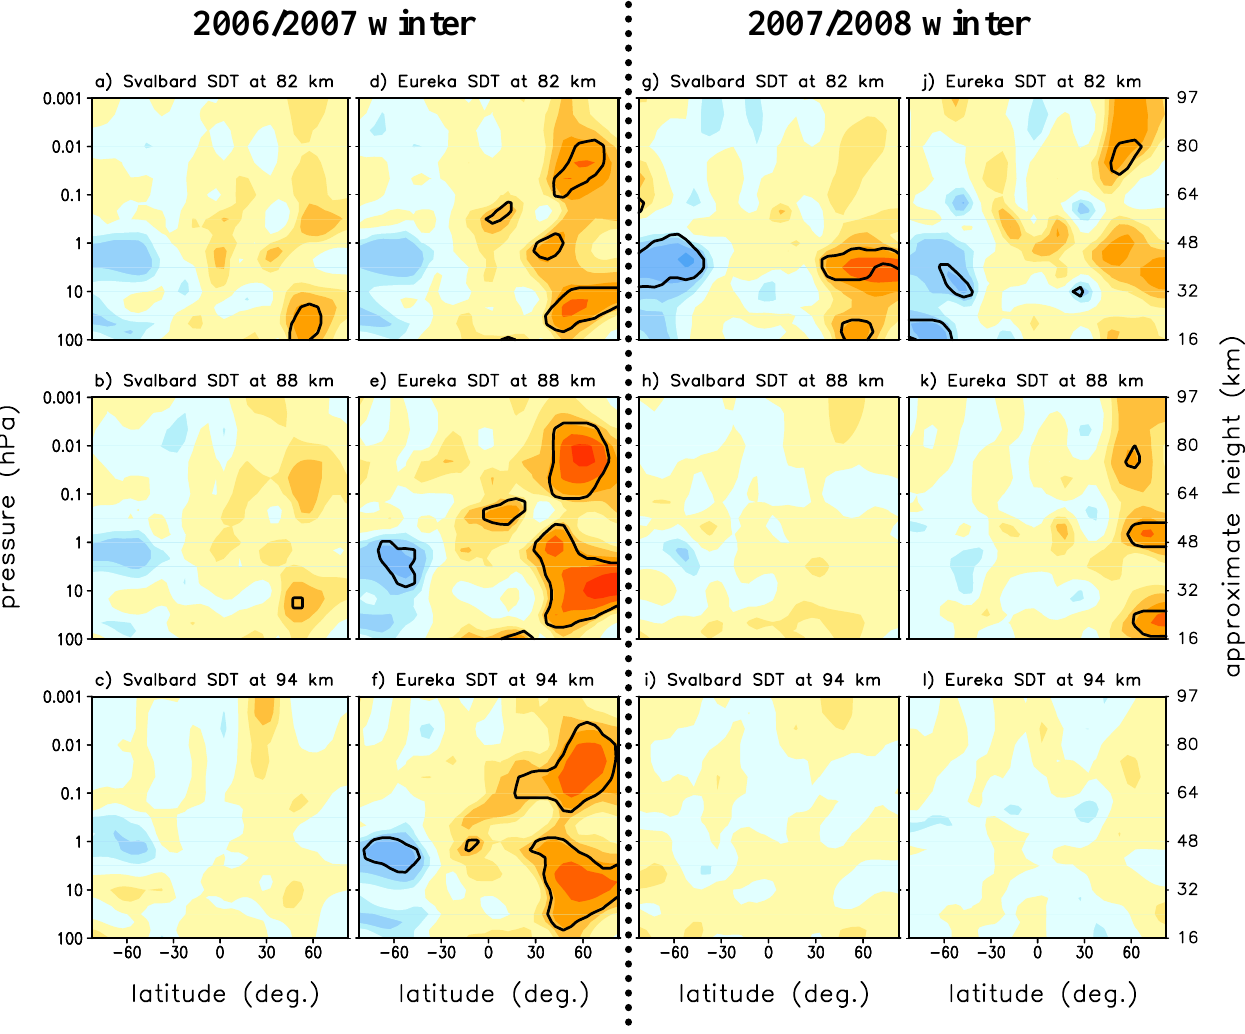
Fig. 7. Correlation coefficients between the stationary planetary wave 1 amplitude at each latitude/pressure with the amplitudes of meridional semidiurnal tides observed at Svalbard and Eureka for 7 November–6 March, 2006/2007 and for 7 November–5 March 2007/2008. Otherwise details are as in Fig.